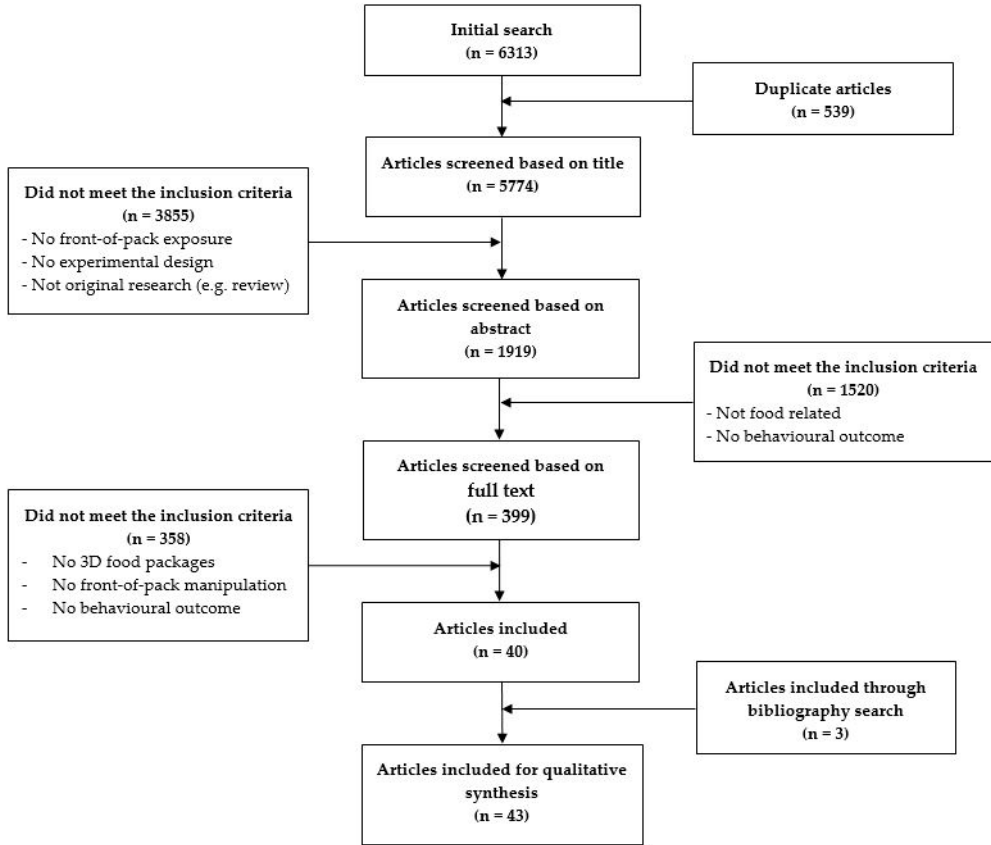
Figure 1. Flowchart depicting the article screening process.